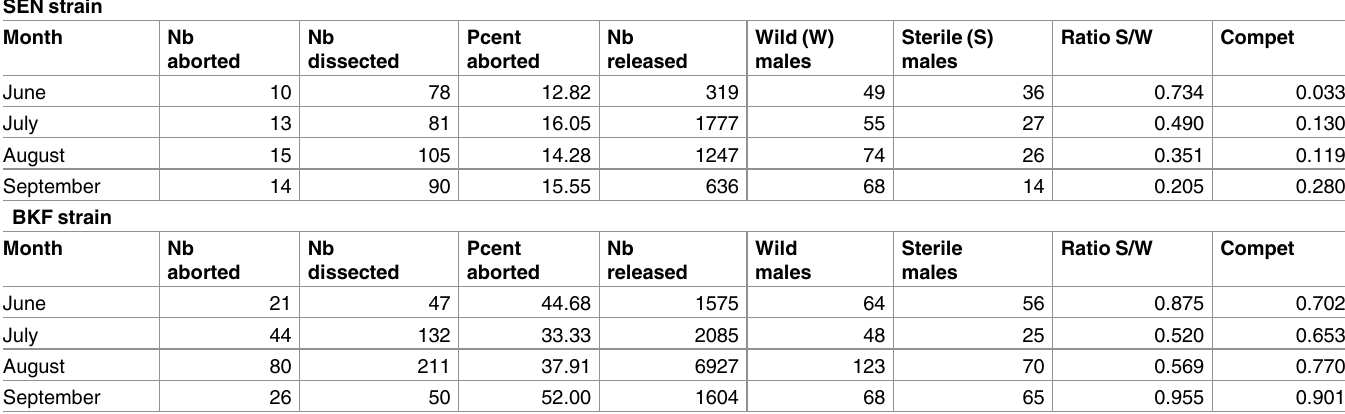
Table 1. Competitiveness of two strains of Glossina palpalis gambiensis in the Parc de Hann, Senegal.